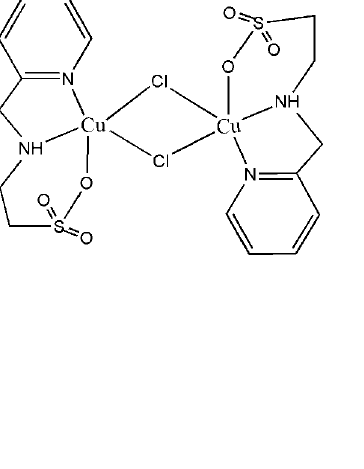
publication: SHELXTL